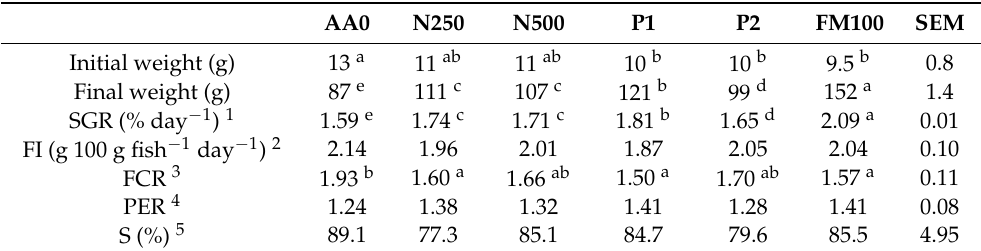
Growth and nutritive efficiency indices of gilthead seabream fed the different experimental